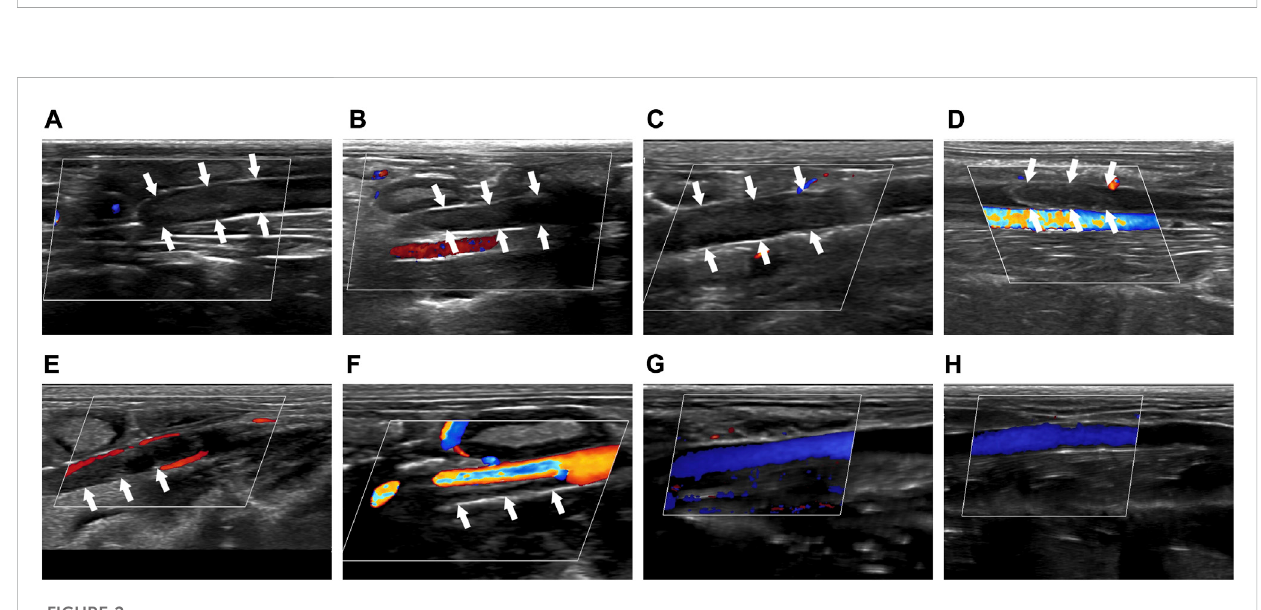
FIGURE 2 Comparison of imaging by CDFI of thrombus before and after treatment. (A – D) Corresponded to the Group I-IV before treatment. (E – H) Corresponded to the Group I-IV after treatment. The white arrow indicated the thrombus in the blood vessel.